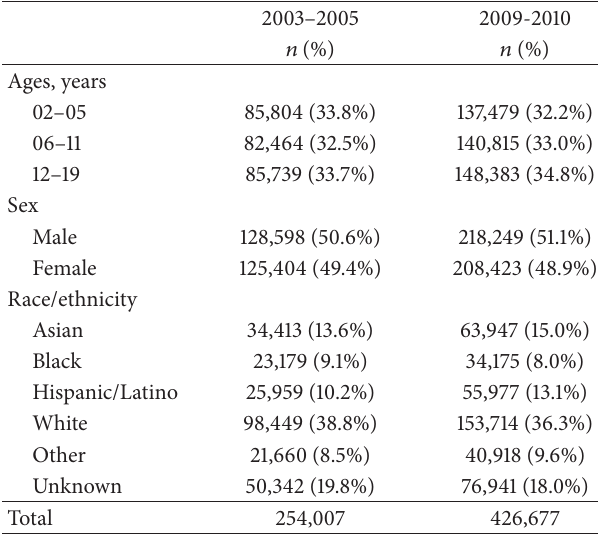
Table 1: Age, sex, and race/ethnicity distributions at each time